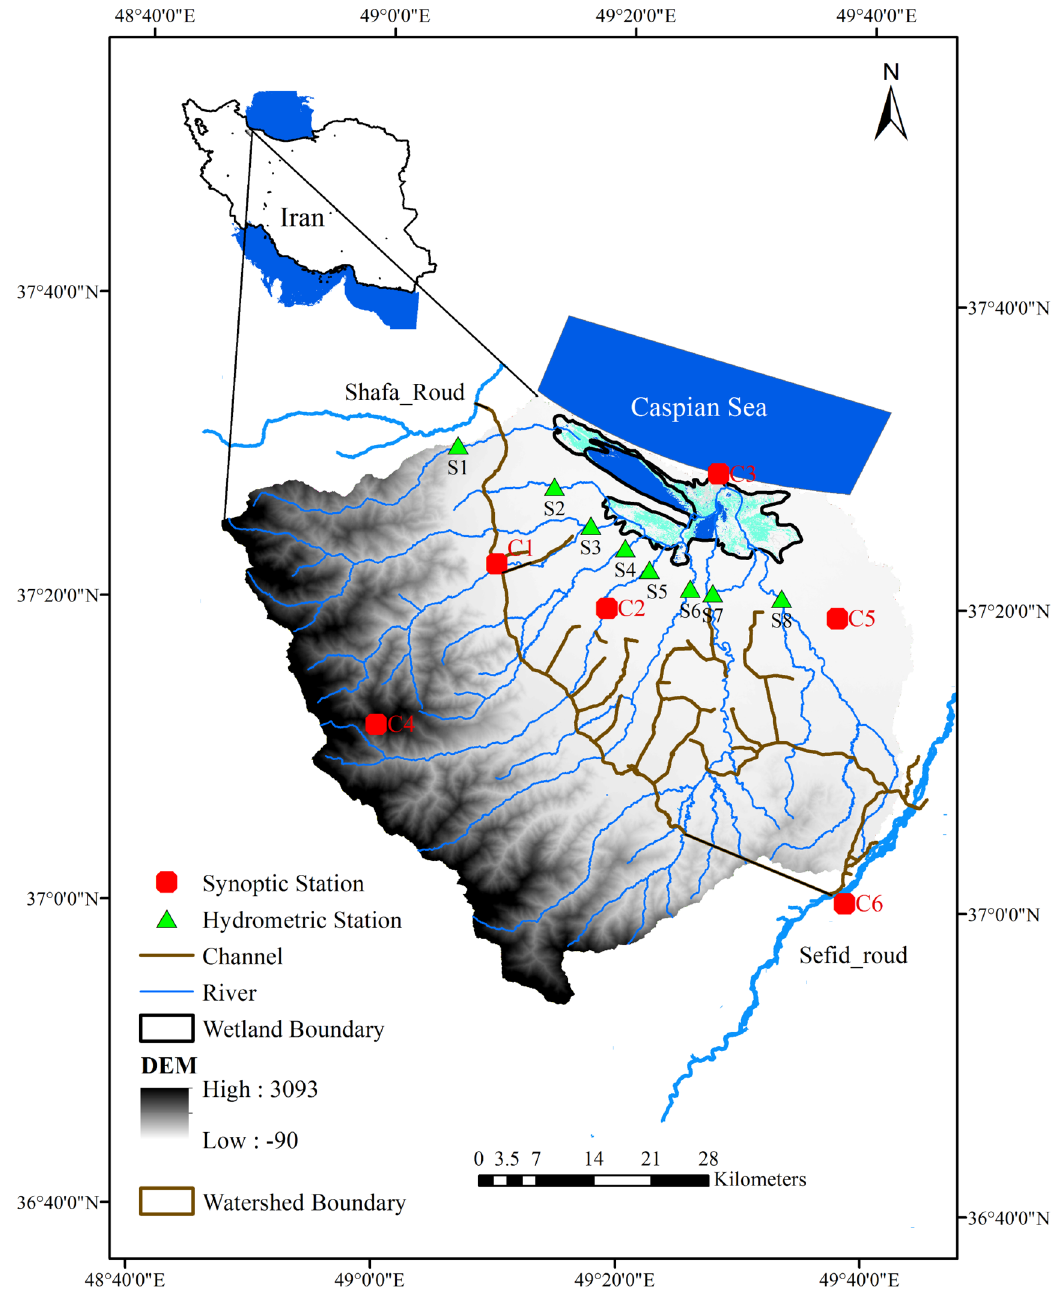
Figure 1. The Anzali wetland watershed (AWW) boundaries with the position of local rivers, hydrometric stations, synoptic stations, deviation channels, and digital elevation map (DEM) (This figure was created in the environment of QGIS, version